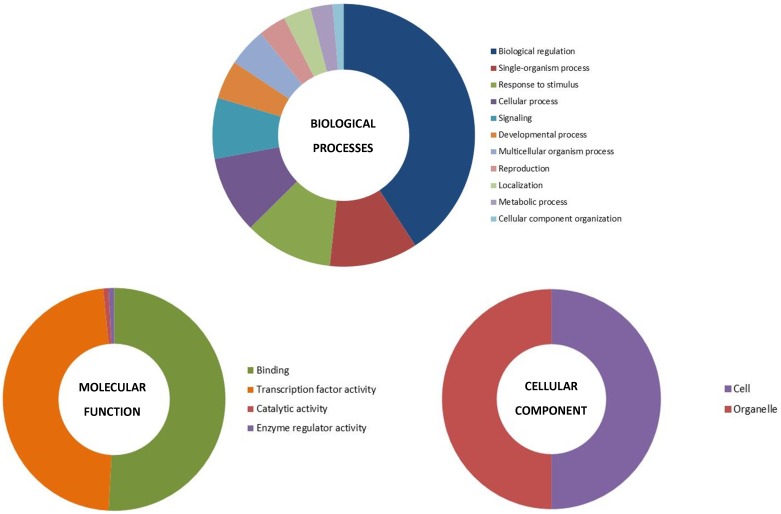
Gene Ontology (GO) distributions for the bZIP proteins.The Blast2Go program defines the gene ontology under three categories (A) biological processes, (B) molecular functions and (C) cellular component.